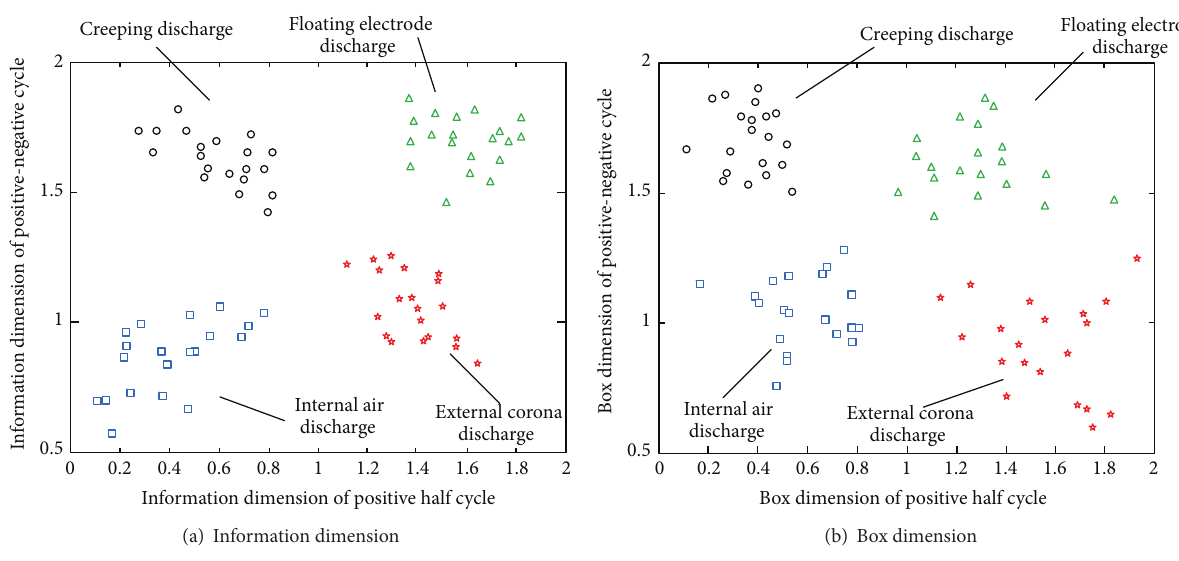
Figure 7: Fractal characteristics of partial